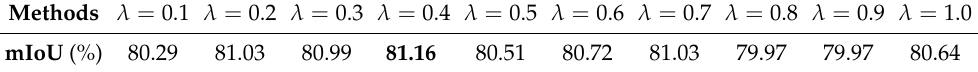
Table 5. Comparison of mIoU with different settings of the λ parameters in Equation (8), which control the size of the auxiliary loss.The blackened numbers represent the best performing group in this set of data.